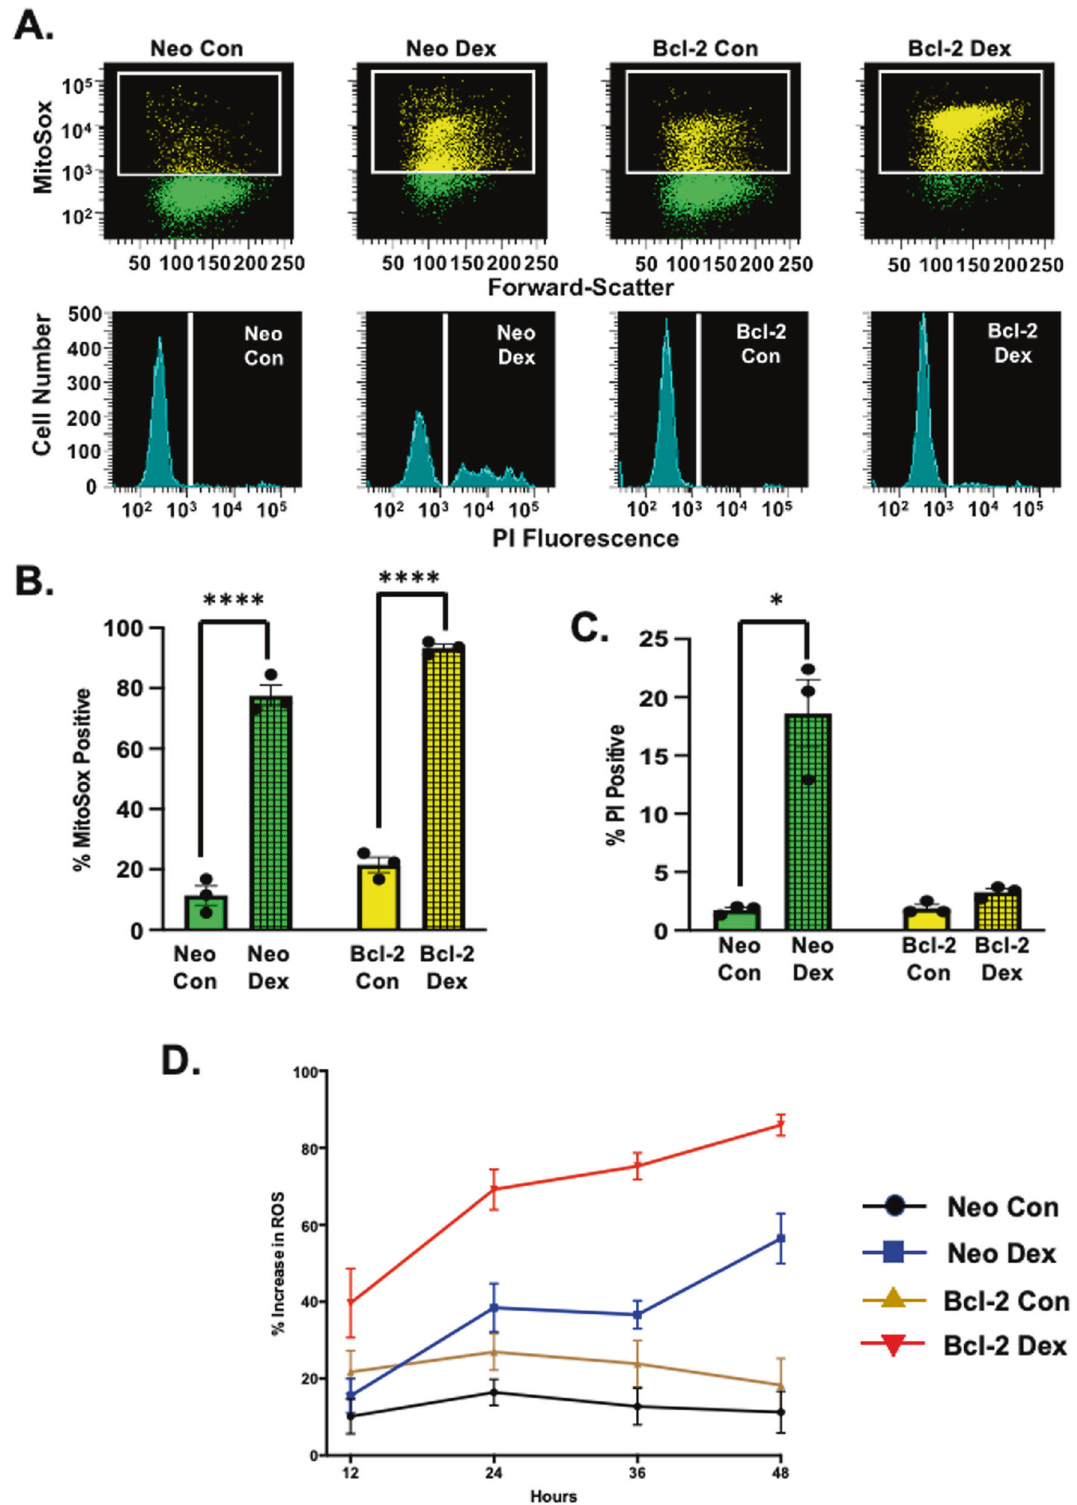
Fig. 3 S49 (Bcl-2) cells treated with dex results in a high percentage of cells with increased reactive oxygen species (ROS). A S49 (Neo) and S49 (Bcl-2) cells treated in the presence or absence of 2.5× 10 − 7 M dex for 48 h were examined for generation of reactive oxygen species (ROS) using MitoSox Red (5 uM, 30min) by fl ow cytometric analysis. S49 (Neo) cells treated with dex showed an increase in ROS that resulted in cell death. Dex-treated S49 (Bcl-2) after 48h resulted in a population of cells with a high level of ROS, without the loss of cell viability. B Quantitation of the change in ROS shown in A . Data represent the mean ( + / − SEM) of 3 independent experiments. C Quantitation of the loss in membrane integrity shown in A . Data represent the mean ( + / − SEM) of 3 independent experiments. D S49 (Neo) and S49 (Bcl-2) cells treated with 2.5 ×10 − 7 M dex were examined for ROS generation over time. Data represent the mean ( + / − SEM) of 5 independent experiments. * p <0.05; **** p < 0.0001.